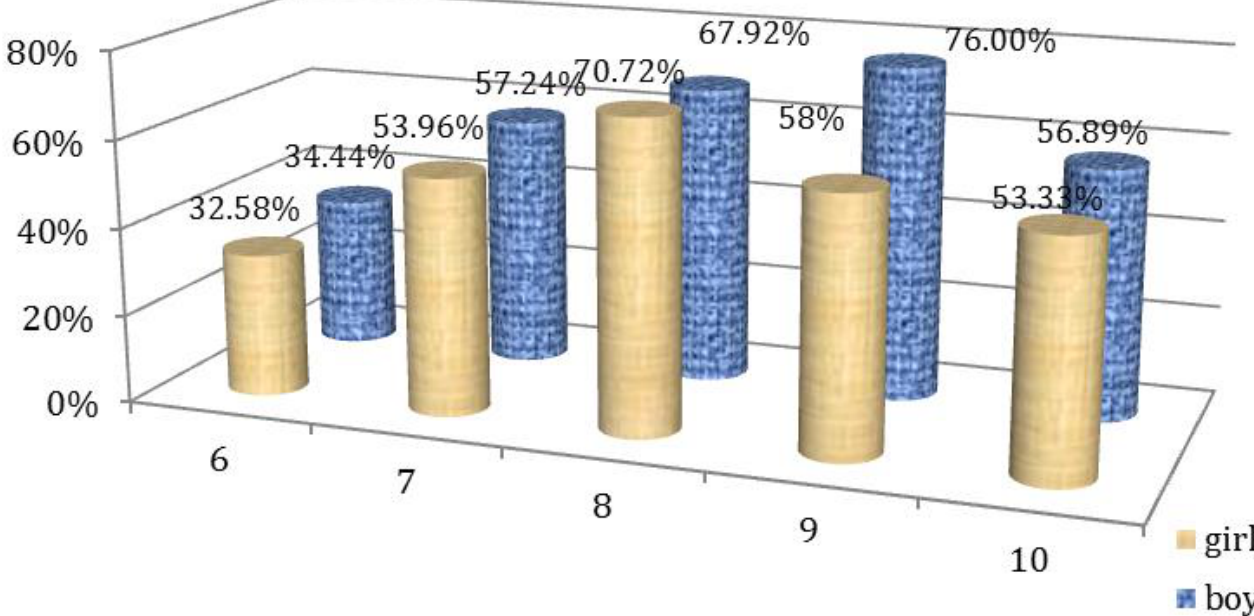
Figure 1. Affirmative answers to questions 1 – 5 of Questionnaire I according to gender.